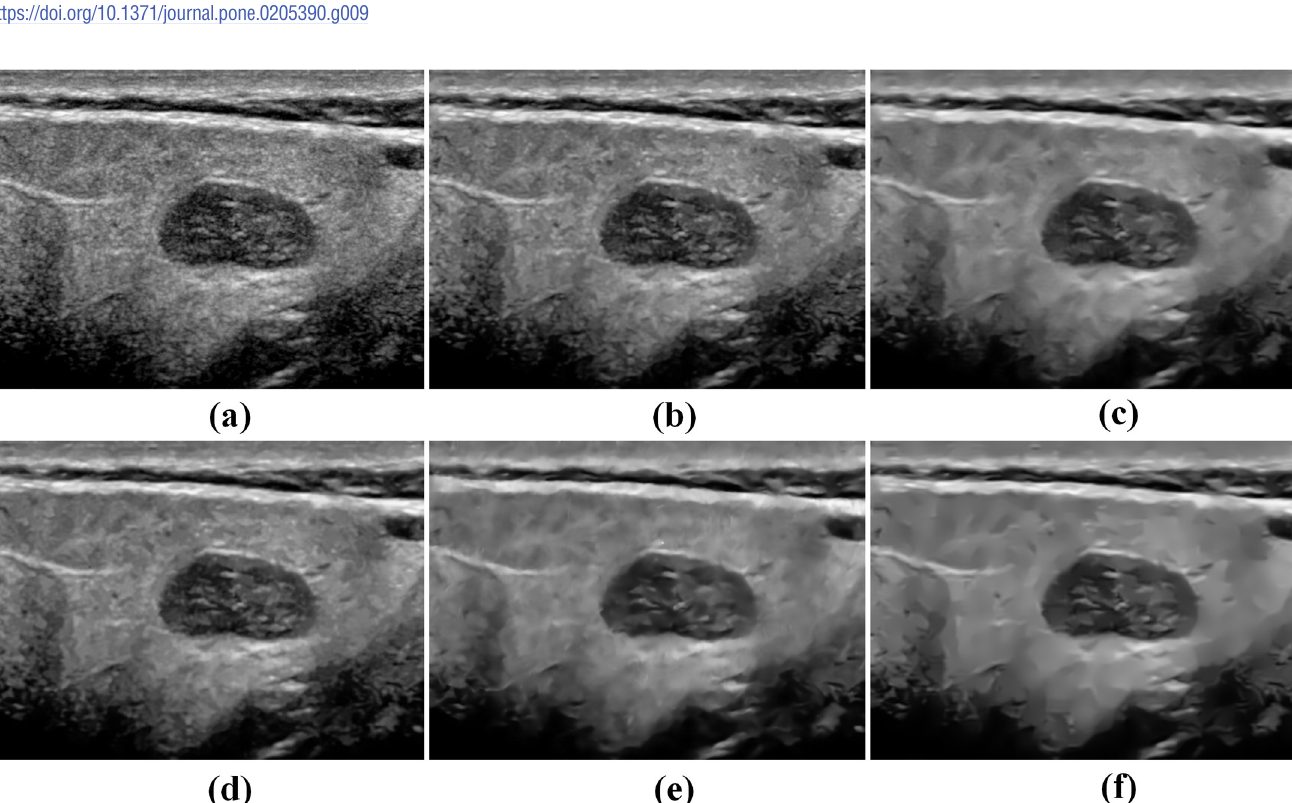
PLOS ONE | https://doi.org/10.1371/journal.pone.0205390 October 12, 2018 16 /